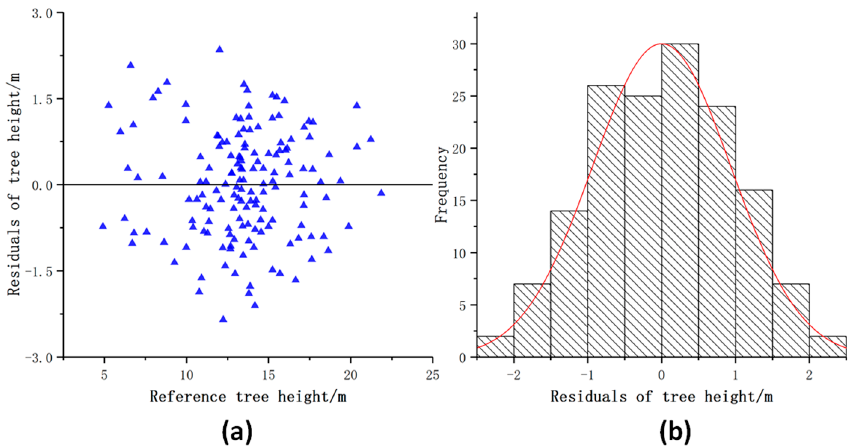
Figure 14. Distribution of the tree height residuals. ( a ) Scatter distribution of tree height residuals; ( b ) Histogram of tree height residuals distribution.